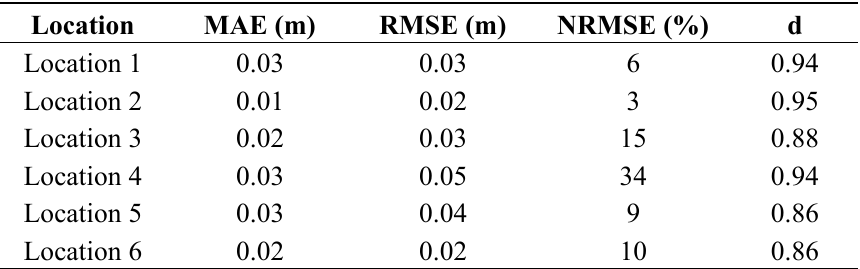
Table 2. Mean absolute error MAE, root-mean-square error RMSE,